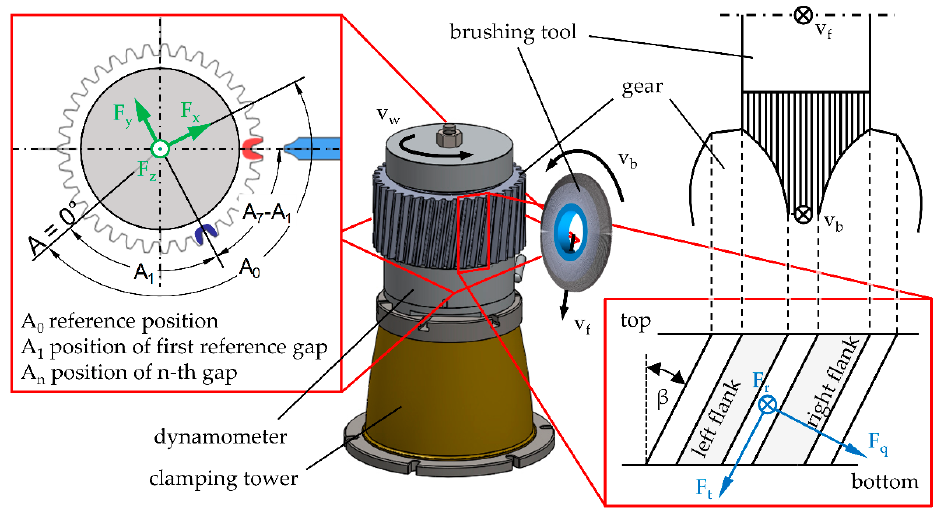
Figure 1. Force measurement for gear machining/finishing.